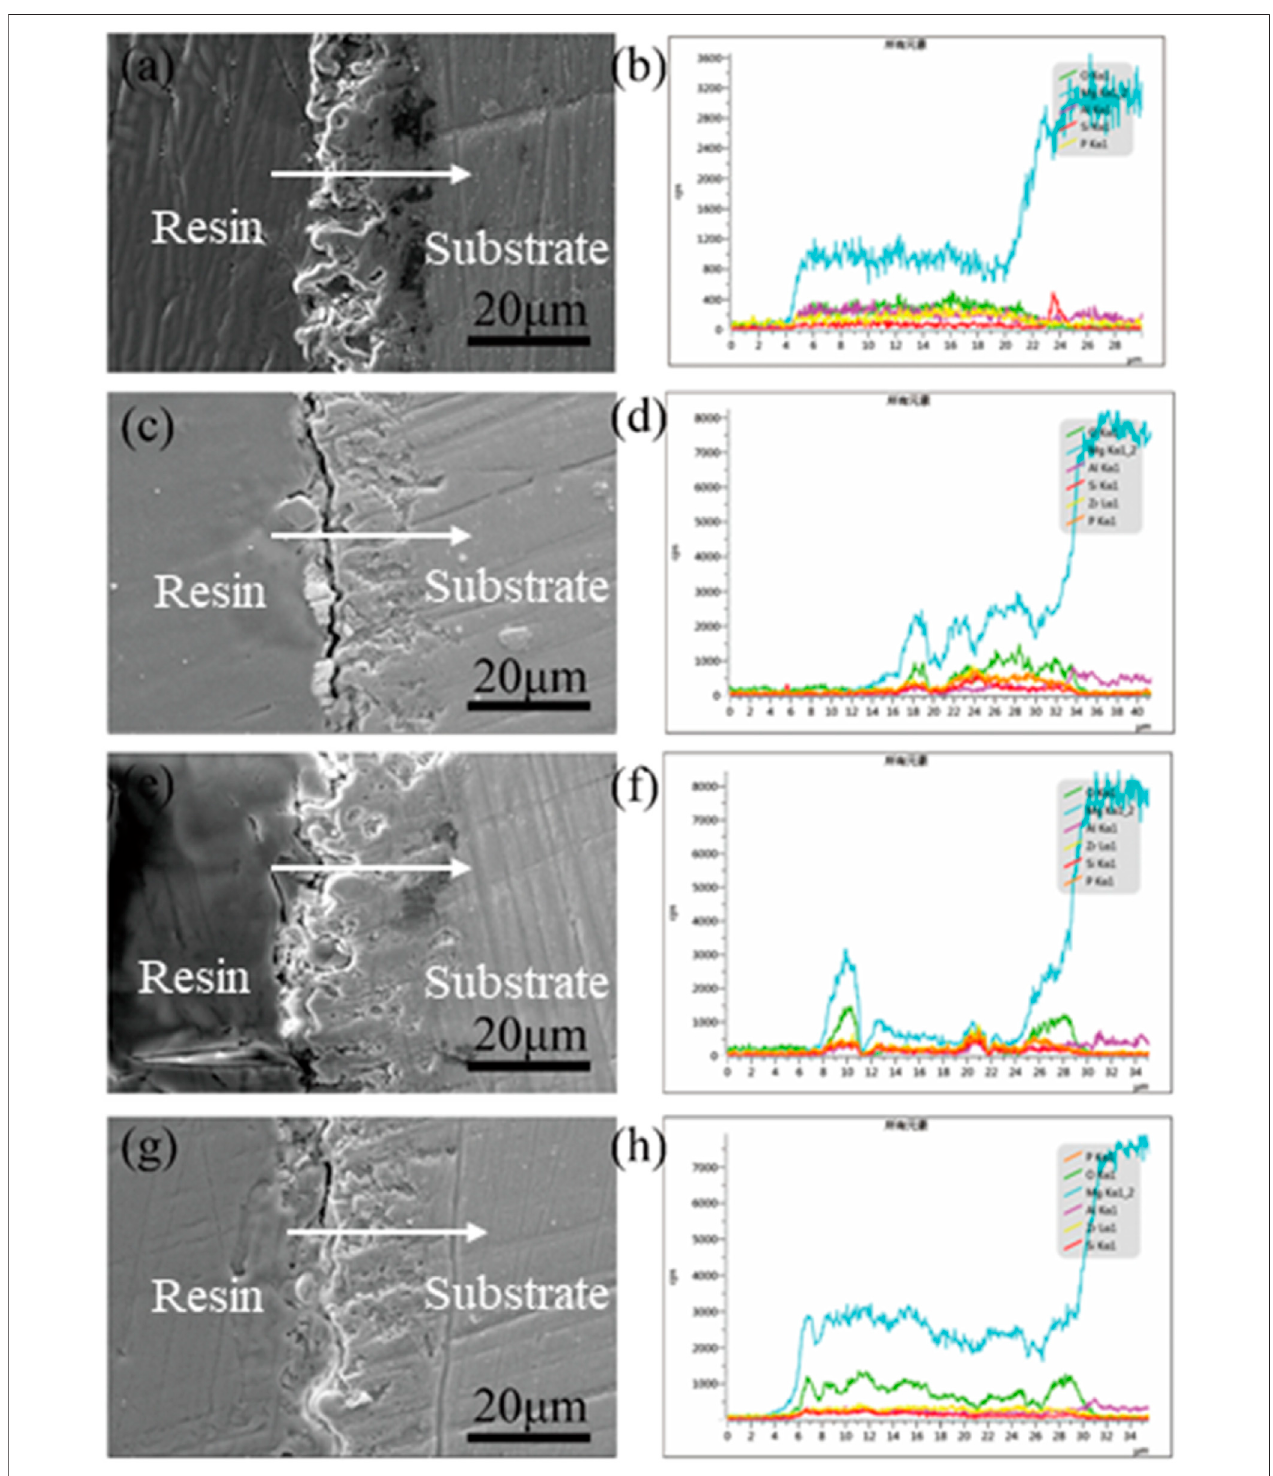
FIGURE 4 | SEM morphologies and EDS results of the cross-sectional views of the different samples (A) AZR0, (B) AZR5, (C) AZR10, and (D) AZR15.